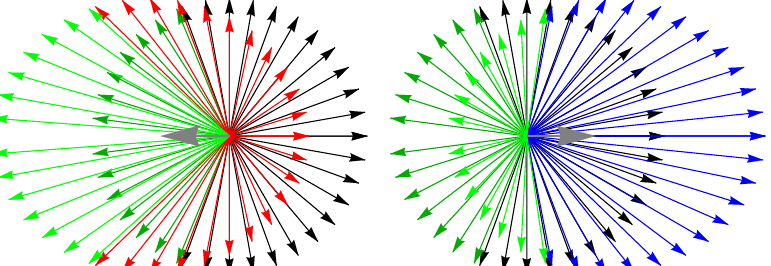
Figure 8. Distribution of the photons with negative and positive energy in the LNRF located in the ergosphere of a Kerr black hole, and the effect of beaming due to the motion in the sense of the black hole rotation ( right ) and in opposite direction ( left ), giving an illustrative explanation of the